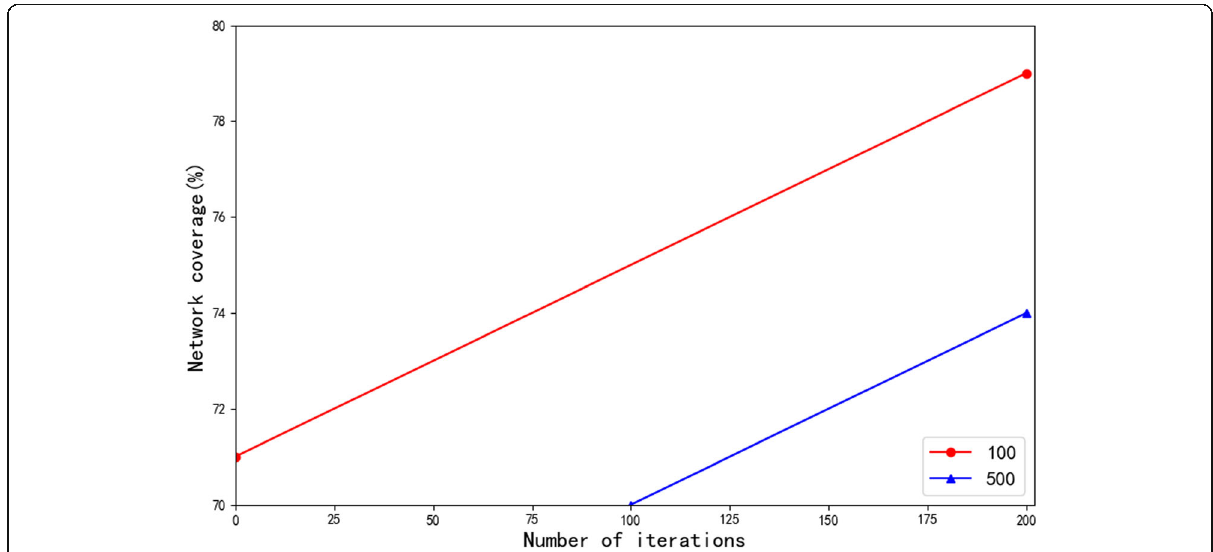
Fig. 4 Comparison of coverage ratios for different iteration number. The population size SizePop is set to 50, the search length L is set to 5 m, and the maximum iteration number Maxgen is set to 100, 200, and 500, respectively. The results are shown in this